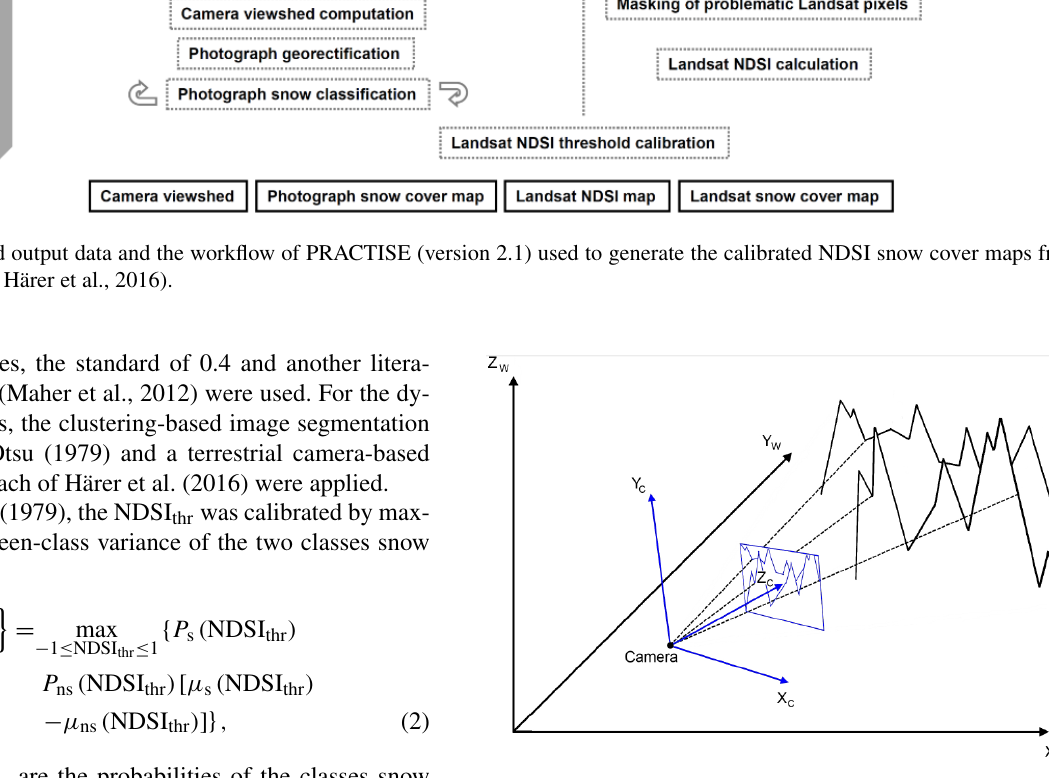
Figure 3. Schematic relationship between the camera location and orientation, and the two-dimensional photograph (blue) and three- dimensional real world coordinate system (black). The dashed line connects the locations of three exemplary ground control points of the photograph with the real world for